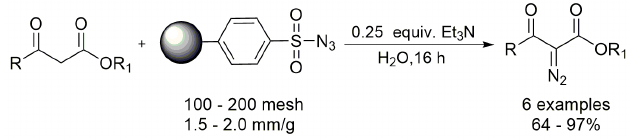
Figure 26 - A green diazo transfer method using polymer-supported benzenesulfonyl azide and catalytic amount of base in